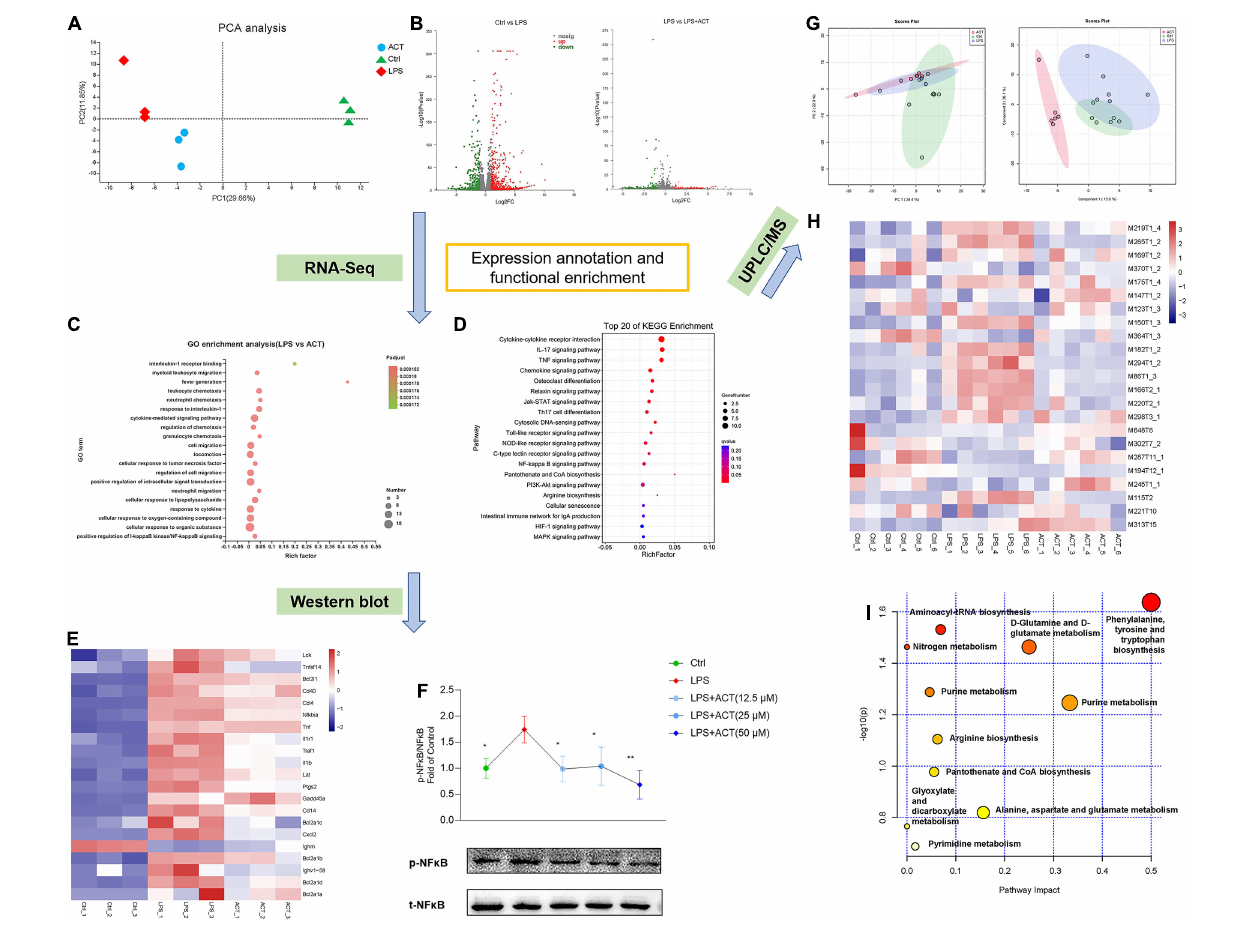
FIGURE 3 | ACT regulated M1/M2 polarization via the inhibition of NF- κ B signaling pathway and positively regulated the metabolism shifts in LPS-induced BV-2 cells. (A) Principal components analysis (PCA) score plot for discriminating the cell metabolome from Ctrl, LPS, and ACT (50 µ M) groups from a transcriptomic level ( n = 3). (B) Volcano plot representing the RNA-seq data of LPS-induced and ACT-treated BV-2 cells. (C) GO terms in ACT-treated cells as determined by GO enrichment analysis. (D) Top 20 pathways in ACT-treated cells as determined by KEGG enrichment analysis. (E) Heat map of the differentially expressed genes (DEGs) that were linked to the NF- κ B signaling pathway. (F) ACT distinctly decreased the phosphorylation level of NF- κ B ( n = 3). * P < 0.05, ** P < 0.01, versus the LPS group. (G) PCA score plot and partial least squares-discrimination analysis (PLS-DA) score plot for discriminating the cell metabolome from Ctrl, LPS, and ACT (50 µ M) groups in positive ion mode. (H) Heat map of the differential metabolites that were altered in the LPS group compared to the Ctrl group and the ACT group compared to the LPS group ( n = 6). (I) The disturbed metabolic pathways in ACT